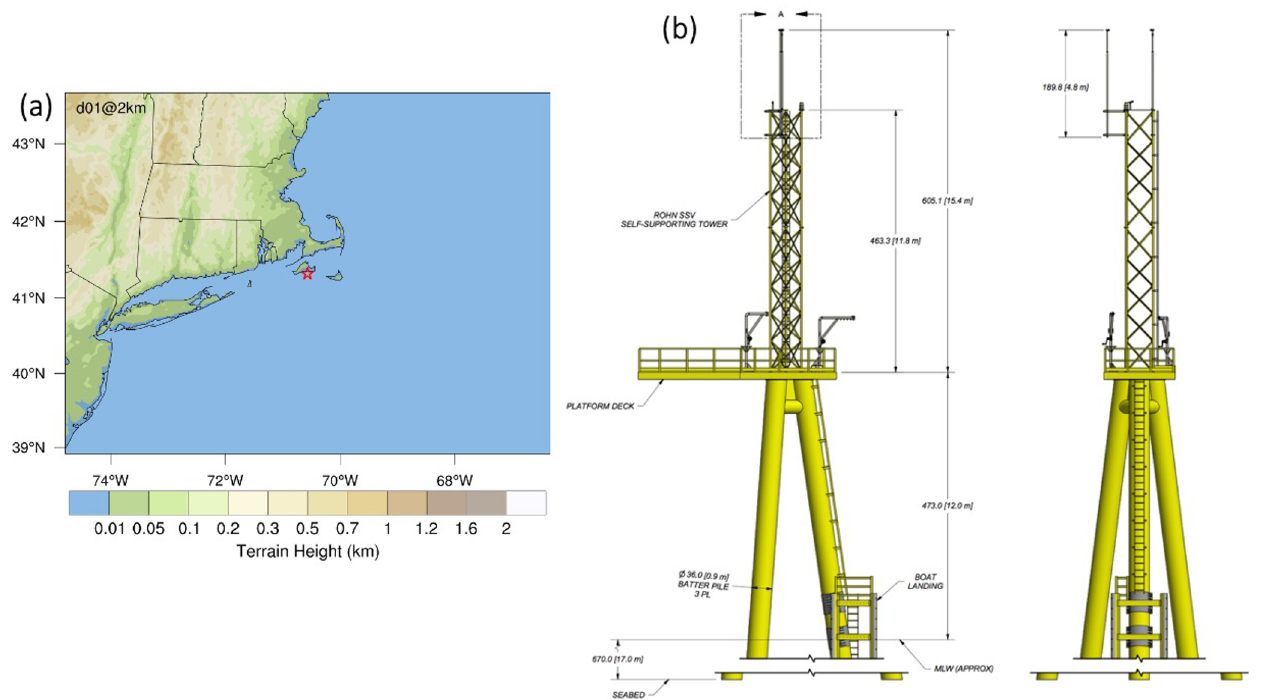
Figure 1. (a) Map depicting the WRF domain used in this study. Red star denotes the location of the MVCO ASIT. Color shading represents the terrain height in kilometers. (b) Schematics of WHOI’s Air-Sea Interaction Tower (ASIT) including all pertinent elevations and dimen- sions of the tower structure and fixed metocean sensors. The reference lidar system is located outboard on the platform deck. MLW denotes mean low